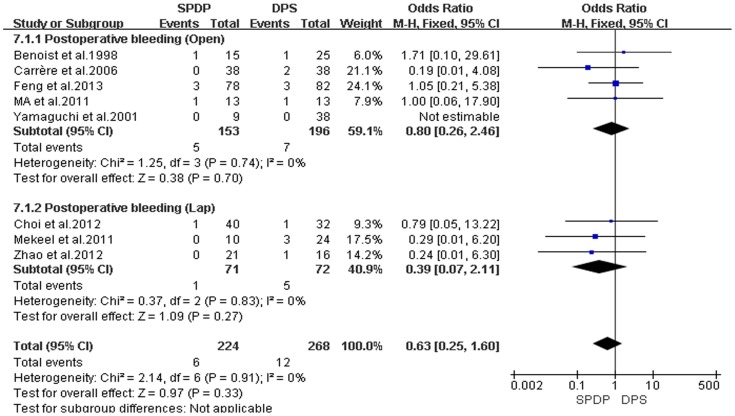
Postoperative bleeding (IV, Inverse variance; M-H, Mantel-Haenszel; CI, Confidence Interval; SD, standard deviation).